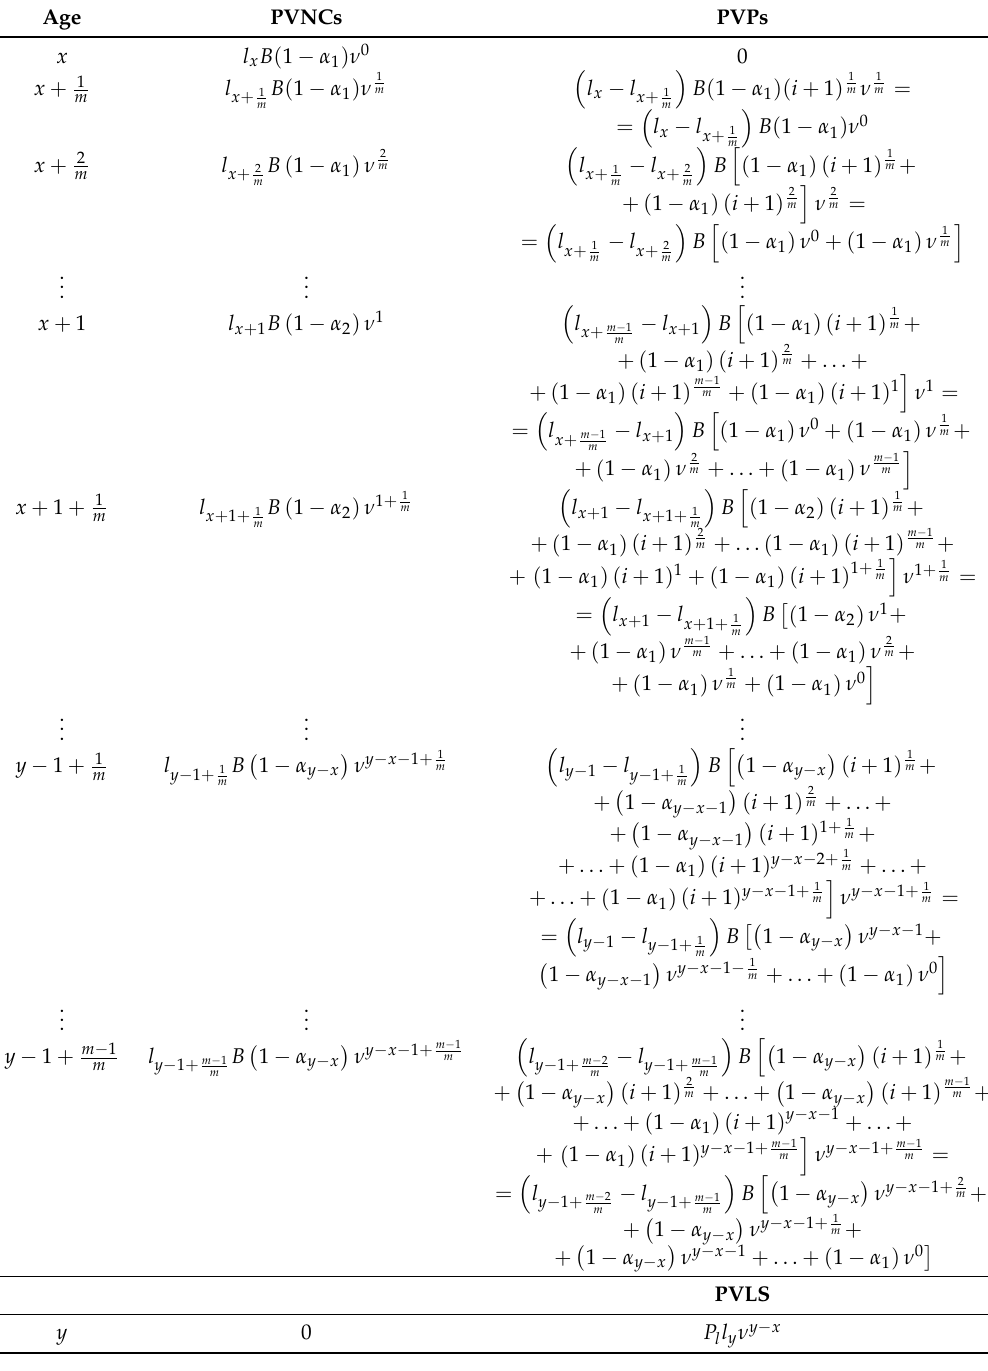
Table 1. Present values of individual net contributions and payments to the inheritors by period (except the last line). The last line consists of the present value of the lump sum